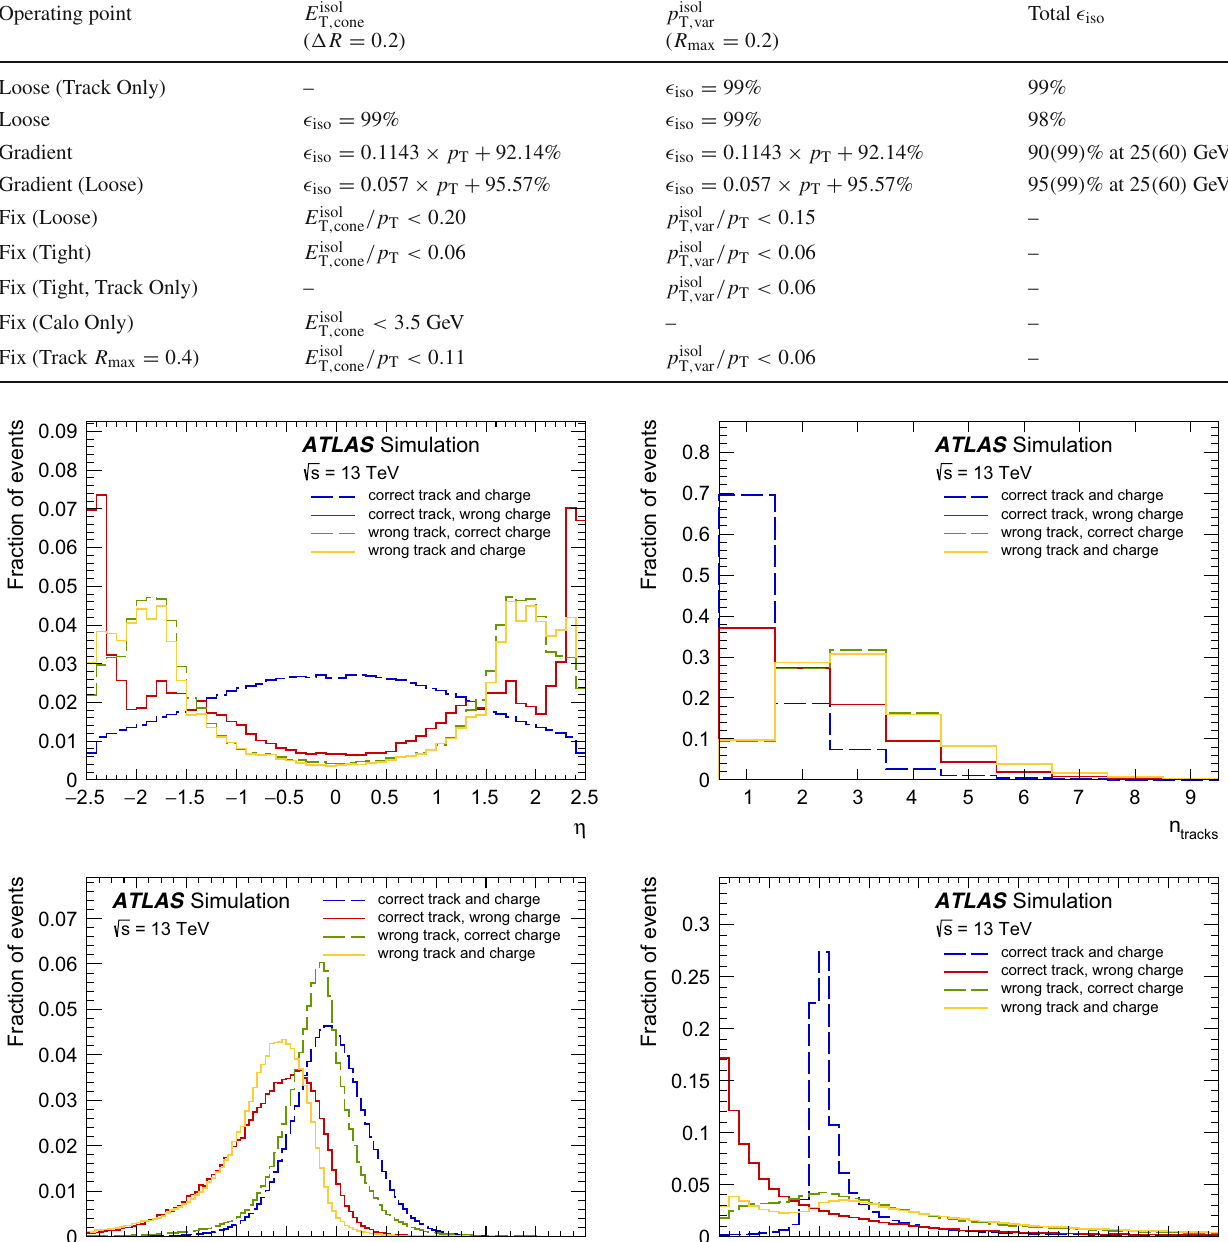
Table 4 Definition of the electron-isolation operating points and isola- tion efficiency (cid:10) iso . For the ‘Gradient’ operating points, the units of p T areGeV.Alloperatingpointsuse aconesizeof (cid:7) R = 0 . 2 forcalorime- ter isolation and R max = 0 . 2 for track isolation except for the final entry